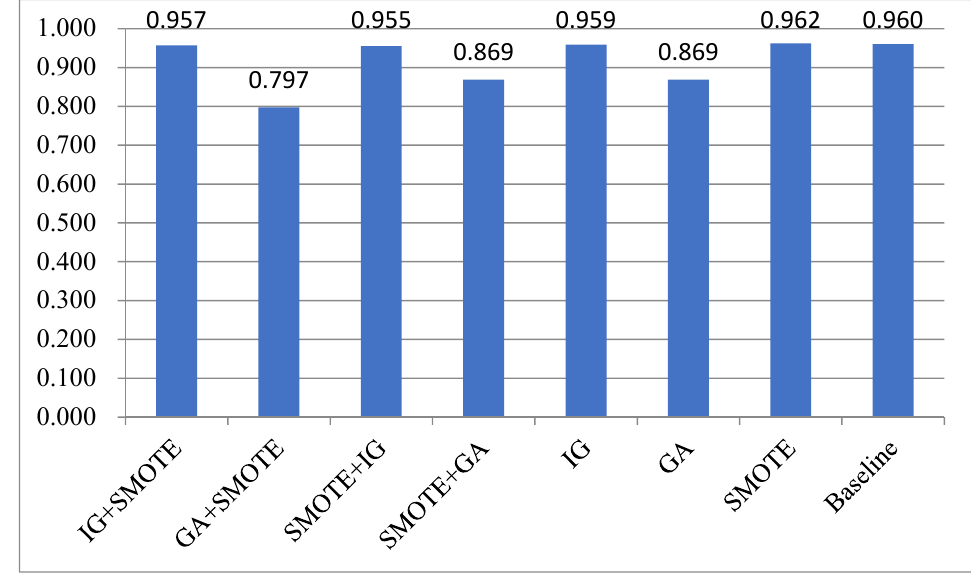
Figure 3. AUC rates of different approaches over the Breast Cancer Wisconsin Dataset.